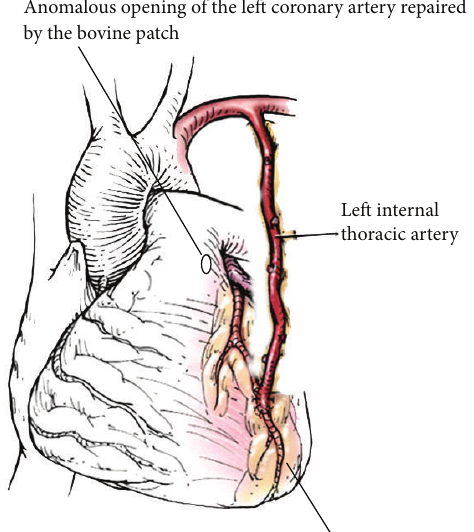
Figure 2: Illustrated representation of the corrective procedure for the anomalous left coronary artery. A bovine pericardium patch was applied into pulmonary trunk to obliterate the anomalous opening of the left coronary artery, while the left internal thoracic artery was used for the anastomosis to the left anterior descending